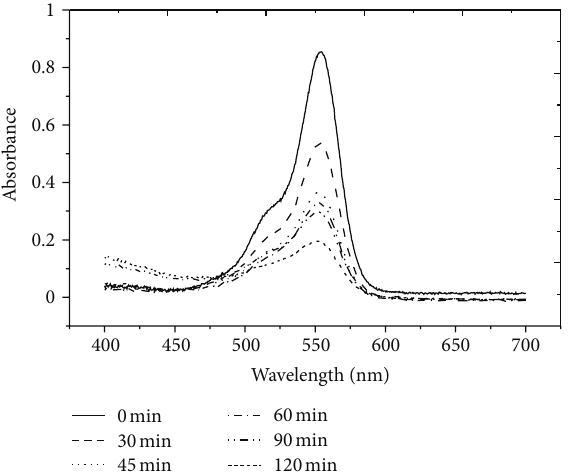
Figure 12: Deterioration of absorption spectra of RhB solutions (553 nm) over a period of UV irradiation time by ZnO NRs.